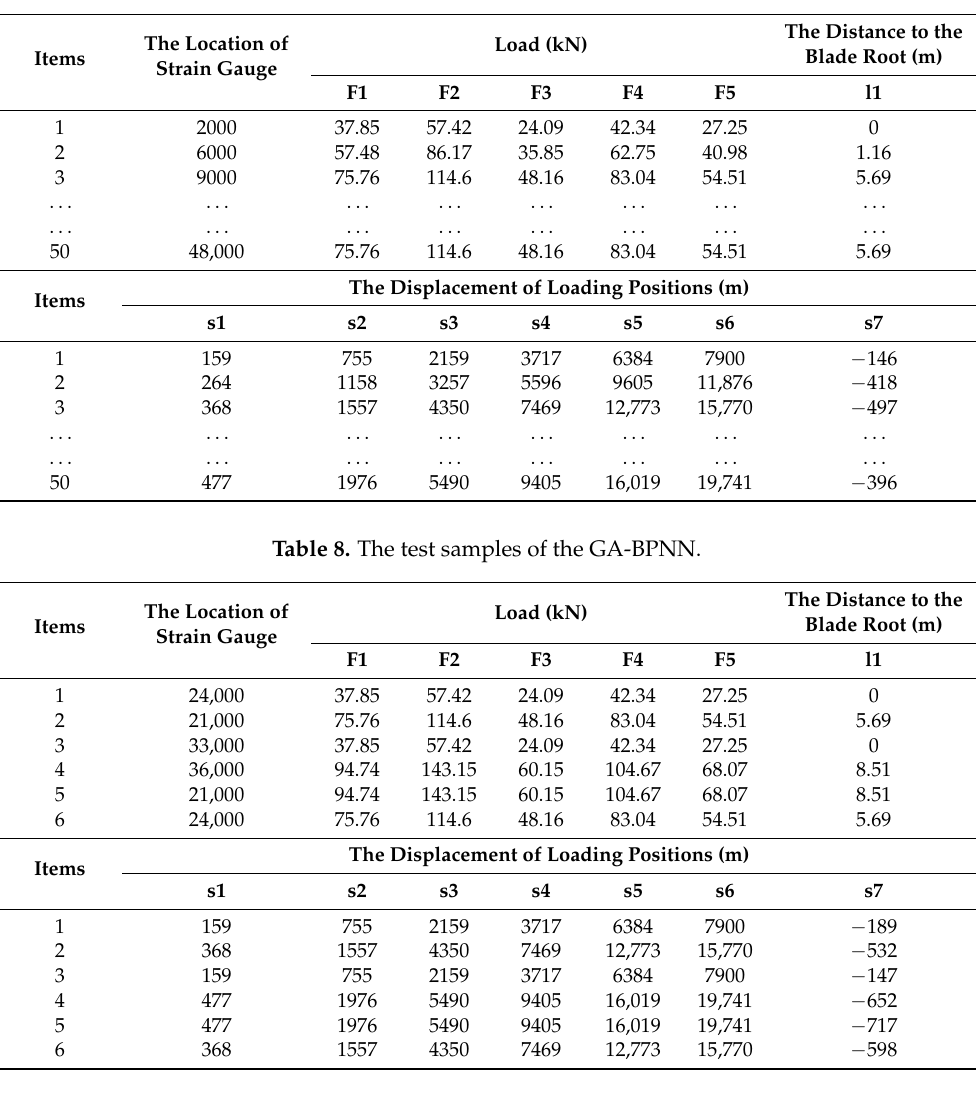
Table 7. The training samples of the GA-BPNN.